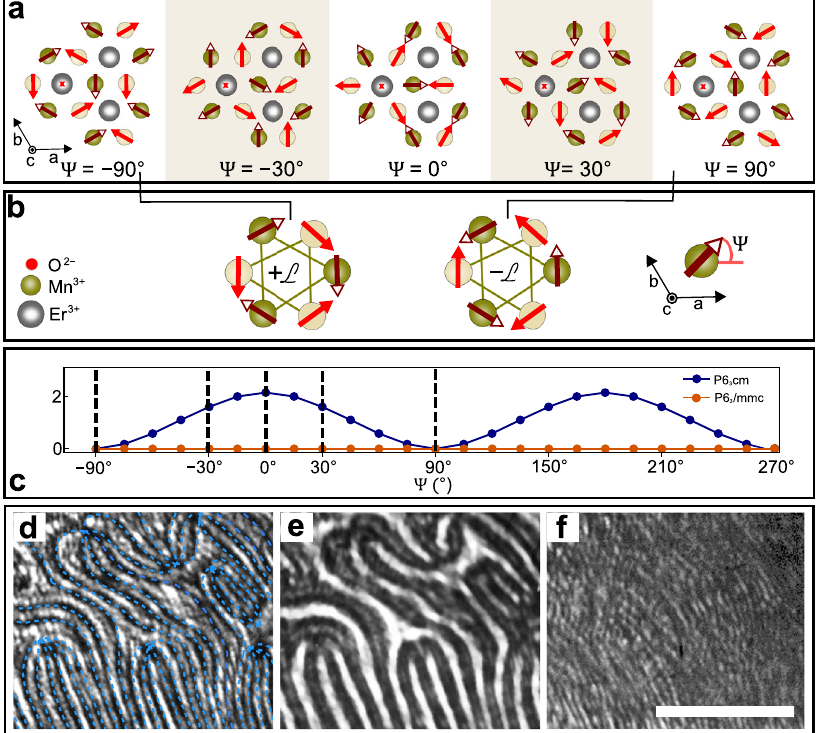
Fig. 2 Antiferromagnetic order of ErMnO 3 . a Top view of the ErMnO 3 unit cell for different values of the Mn 3 + spin angle Ψ . Dark (bright) circles and arrows refer to Mn 3 + ions in the upper (lower) half of the unit cell. b Phenomenological association of the two antiferromagnetic domain states for Ψ = ±90 ∘ to þ L and (cid:2) L . The inset with the coordinate system de fi ning Ψ , in the bottom right, takes the Mn 3 + ion in the centre of the three Er 3 + ions in a as origin. c Magnetoelectric bulk coupling energy Δ E as function of the Mn 3 + spin angle Ψ . Calculated using DFT in the absence (orange) and presence (blue) of the distortive-ferroelectric order. d – f Spatially resolved distribution of SHG intensity on the same region of a c -oriented ErMnO 3 sample for the SHG coupling to P , L and PL , respectively. Black lines — highlighted with dashed blue lines — in d indicate ± P domain walls, and dark and bright regions in e distinguish ± L domains. In either case, the brightness difference results from SHG interference processes 24,26 . For the assignment of ± P domains in d , see Fig. S2. SHG images were taken at room temperature ( P ) or 20 K ( L , PL ). Scale bar in f is 25 μ